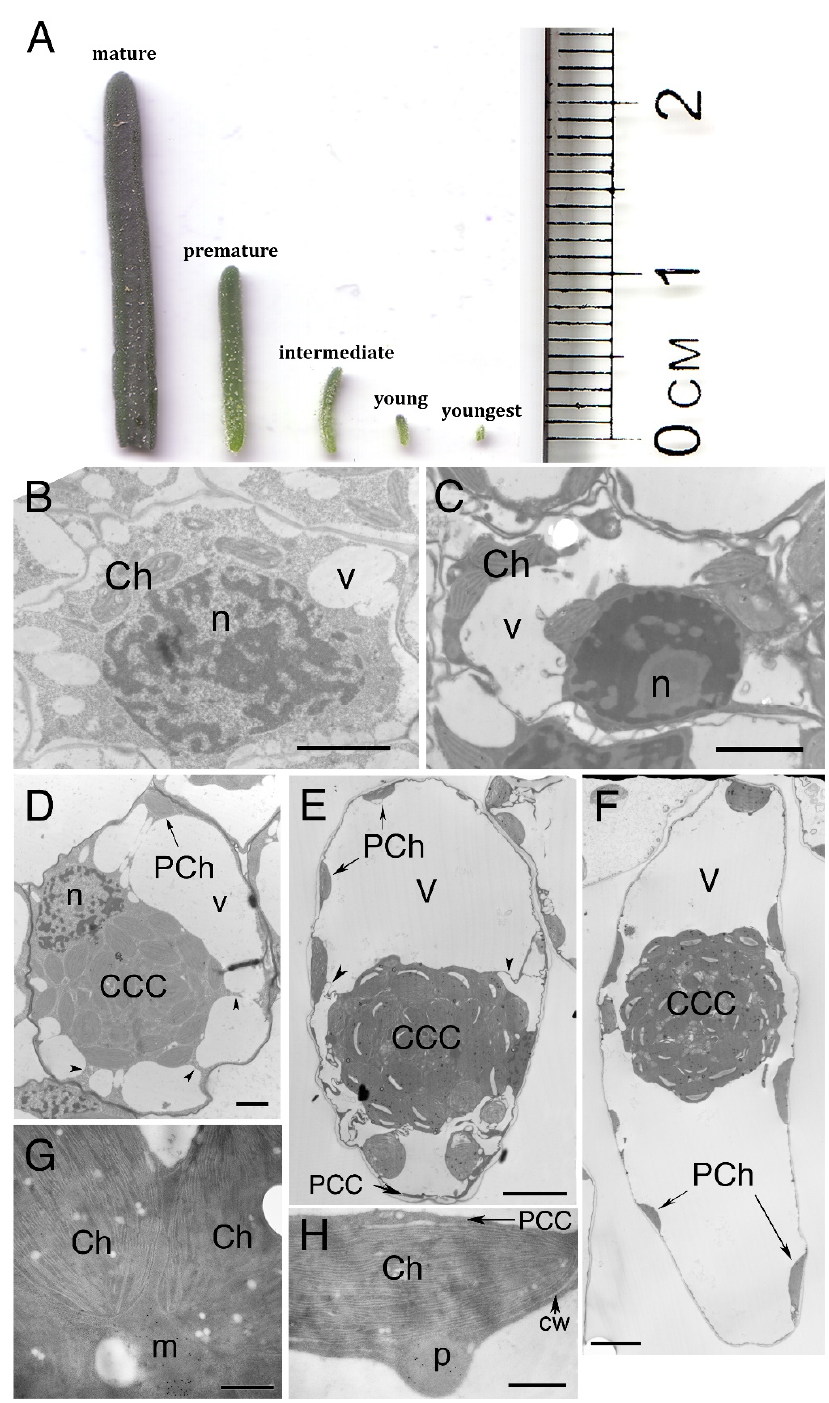
Figure 1. Transmission electron micrographs of chlorenchyma cells in developing leaves of B. sinuspersici . ( A ) Leaves were categorized into five developmental stages depending on their length: youngest (0.1 cm), young (0.2 cm), intermediate (0.5–0.6 cm), premature (1.0–1.2 cm), and mature (>2 cm). Transmission electron micrographs of chlorenchyma cells in ( B ) youngest, ( C ) young, ( D ) intermediate, ( E ) premature, and ( F ) mature leaves of B. sinuspersici . ( G ) Ultrastructure of chloro- plasts in the CCC. ( H ) Ultrastructure of chloroplast in the PCC. Arrows, cytoplasmic strands; CCC, central cytoplasmic compartment; PCC, peripheral cytoplasmic compartment; Ch, chloroplast; cw, cell wall; m, mitochondrion; n, nucleus; p, peroxisome; PCh, PCC chloroplasts; v, vacuole; Bars = 2 µ m in ( B – D , G , H ), 10 μ m in ( E , F ).